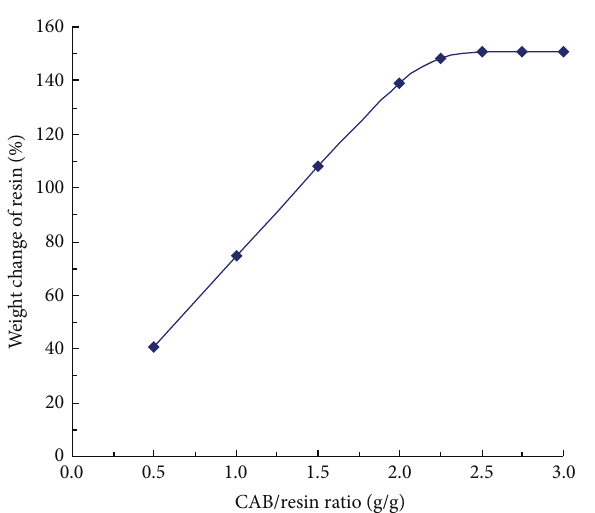
Figure 3: Stabilizing impregnating extractant capacity on the resin weight change after stabilizing extractant content of EIR beads by carrying out sorption-desorption cycles.